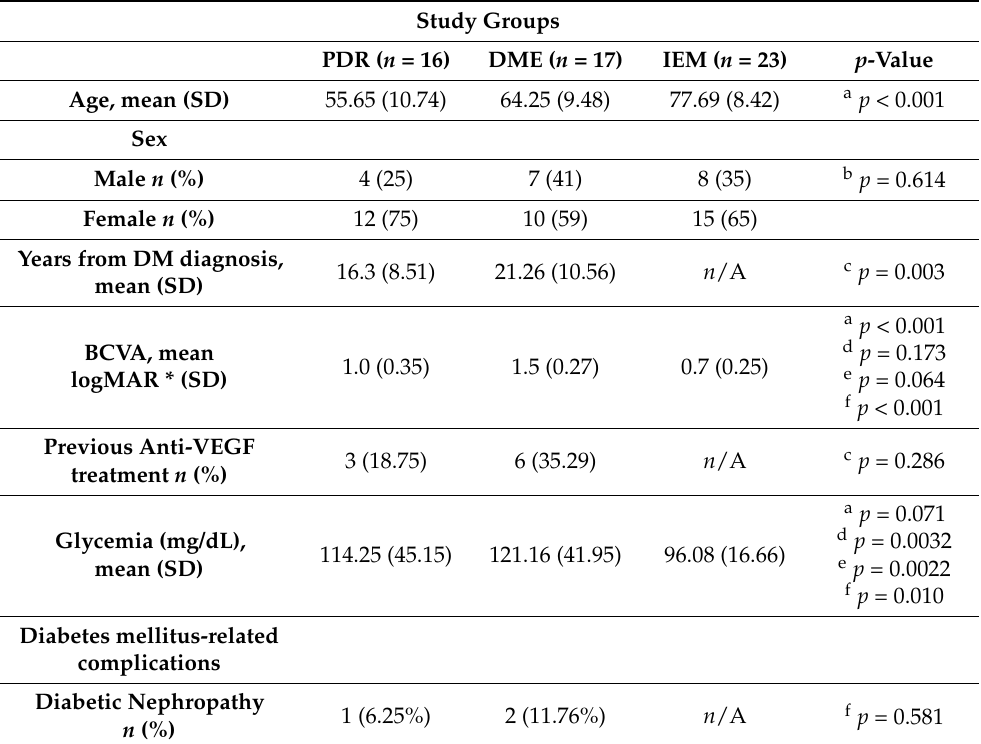
Table 1. Clinical and demographical features of study groups.